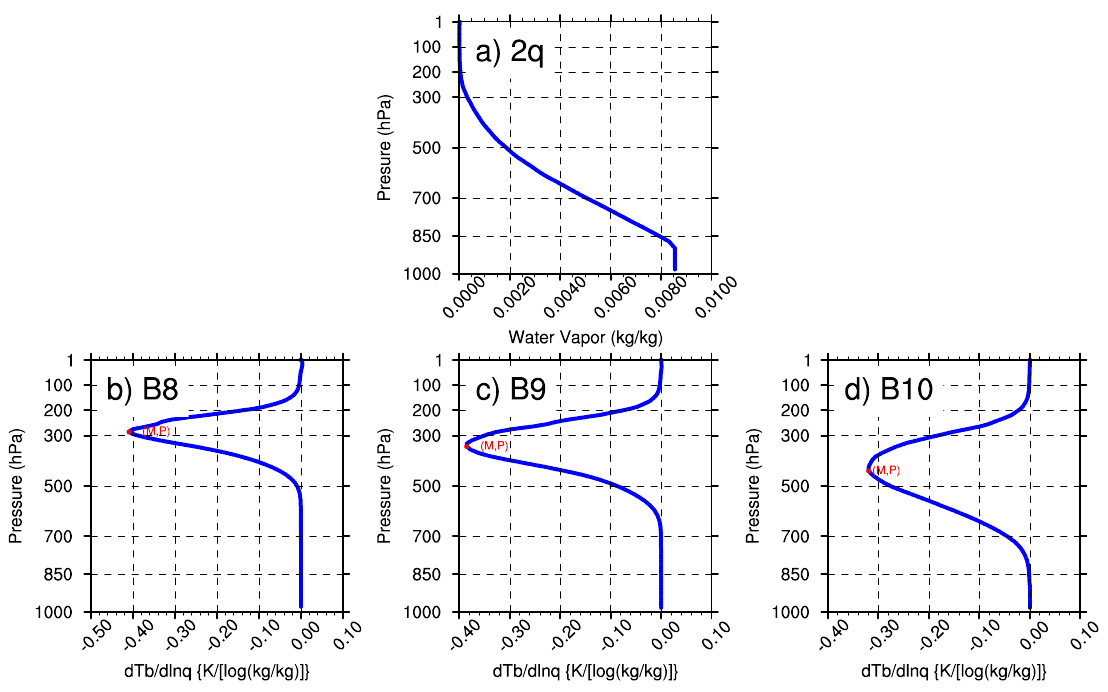
Figure 5. ( a ) Double water vapor content in Figure 3a. ( b )–( d ) Corresponding Jacobian Functions (M) and the height of BWIL (P) of Band 8, Band 9 and Band 10, respectively.